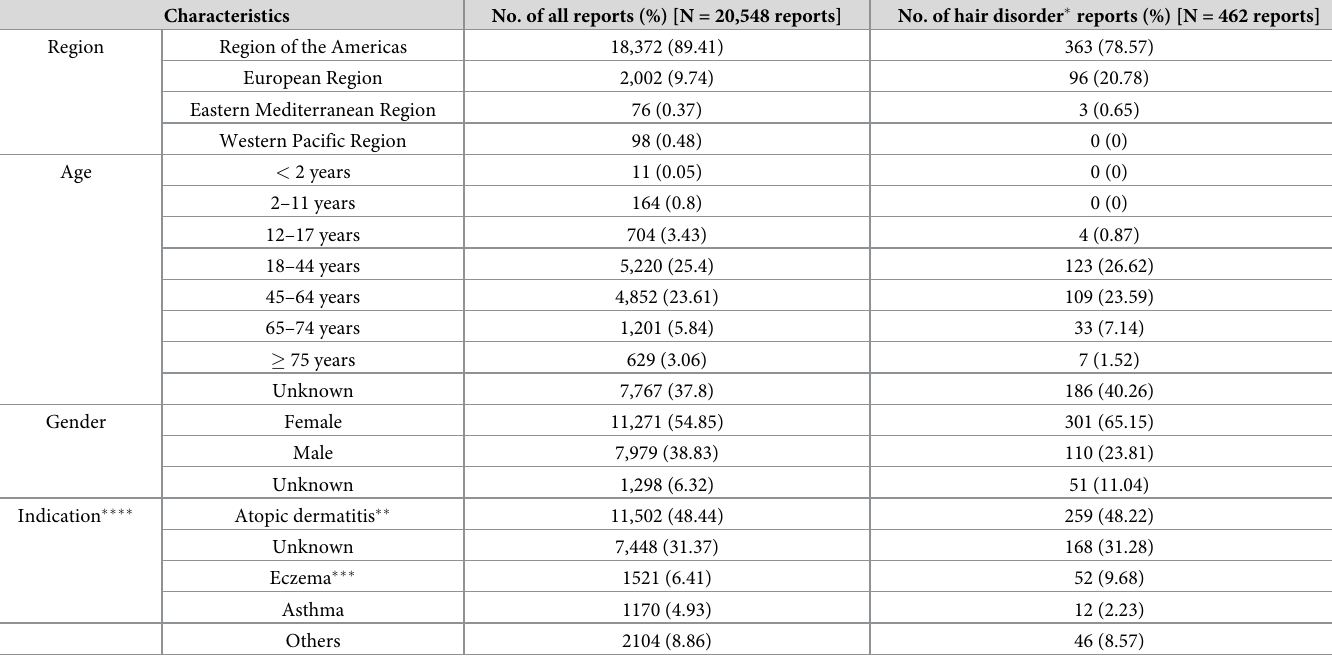
Table 3. Demographic characteristics of dupilumab-related adverse event